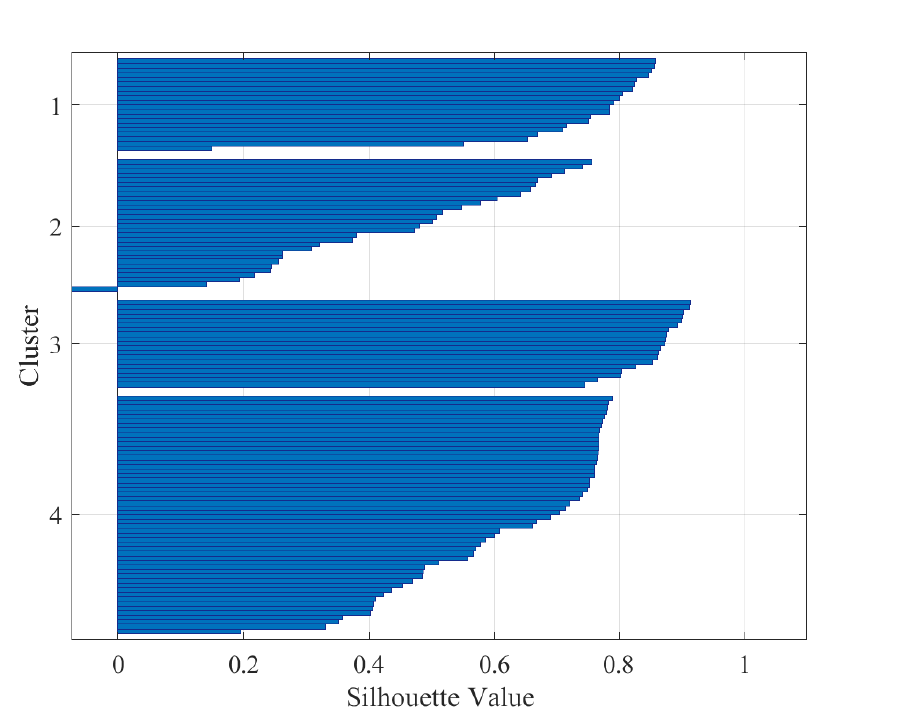
Figure 14. Silhouette plot of clustered stator voltage harmonics data with k =